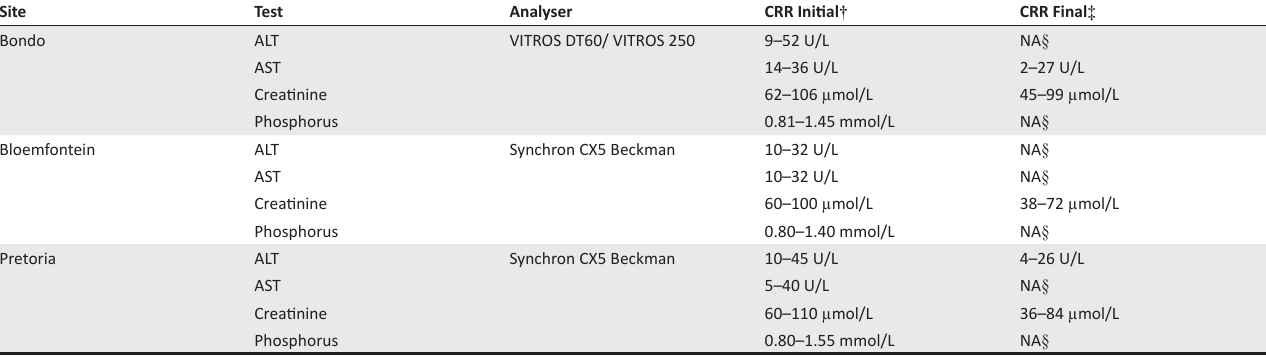
TABLE 2: Initial and revised chemistry reference range values for each study site. Site